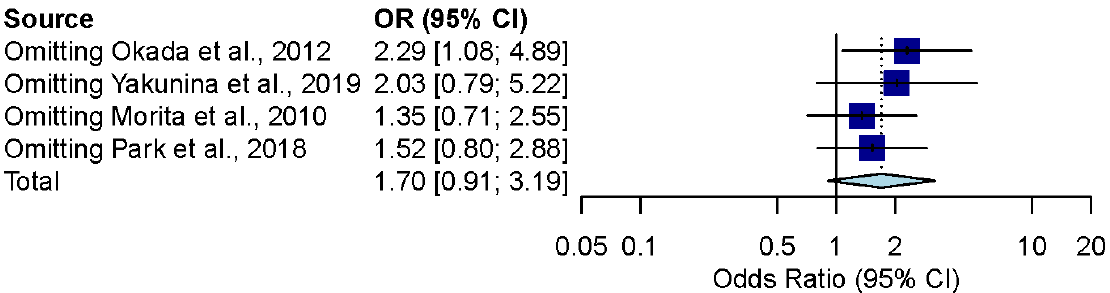
Figure 4. Influence analysis for the overall effect of steroid and combination therapy in ALHL pa- tients [9–11,20].